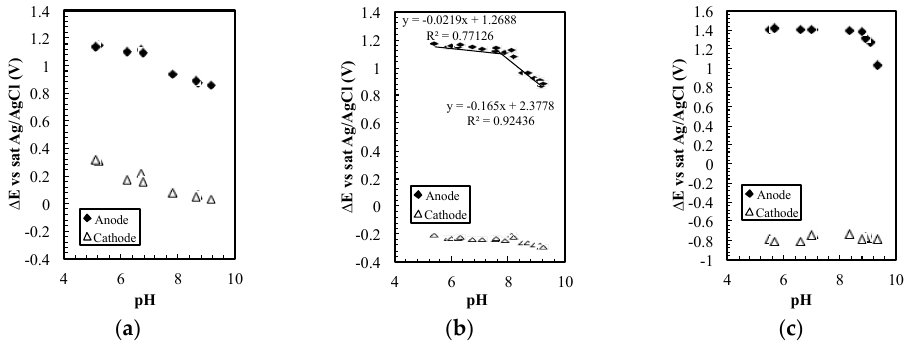
Figure 4. ( a ) The potential on the cathode and the anode versus saturated Ag/AgCl reference electrode at 0.05 μ A, ( b ) 0.15 μ A, and ( c ) 1.0 μ A.